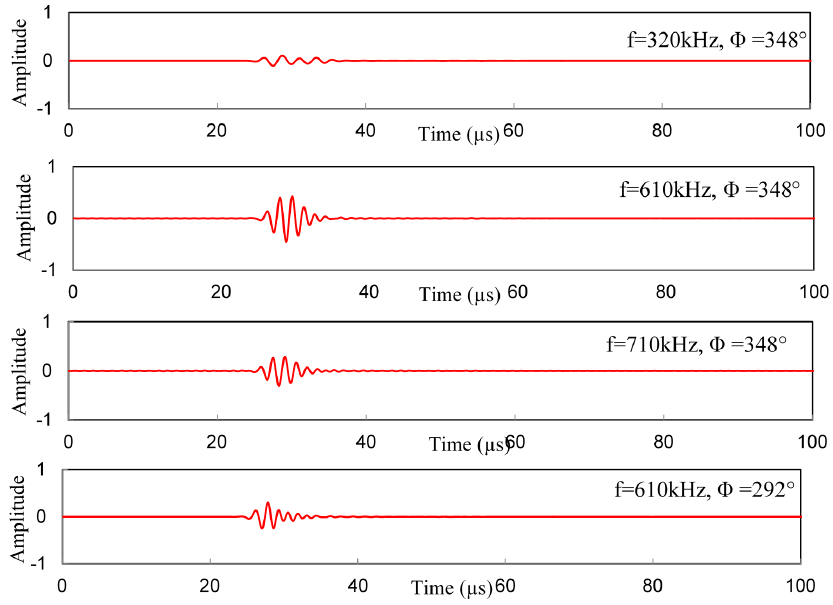
Figure 11. A simplified case of the multiple-rivet-hole problem.